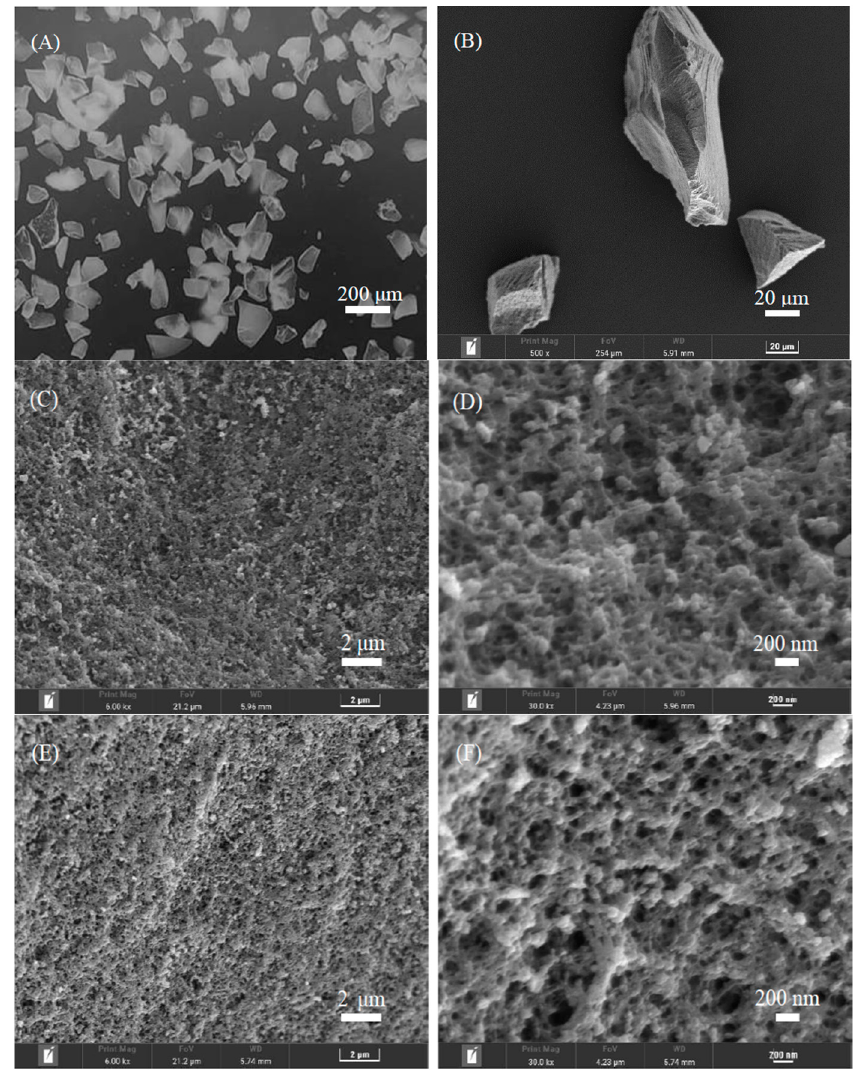
Figure 4. Morphology characterization of (ChCl-MAA)DES@MIPs ( A , B , C , D ) and (ChCl-MAA)DES@NIPs ( E , F ) determined by SEM.